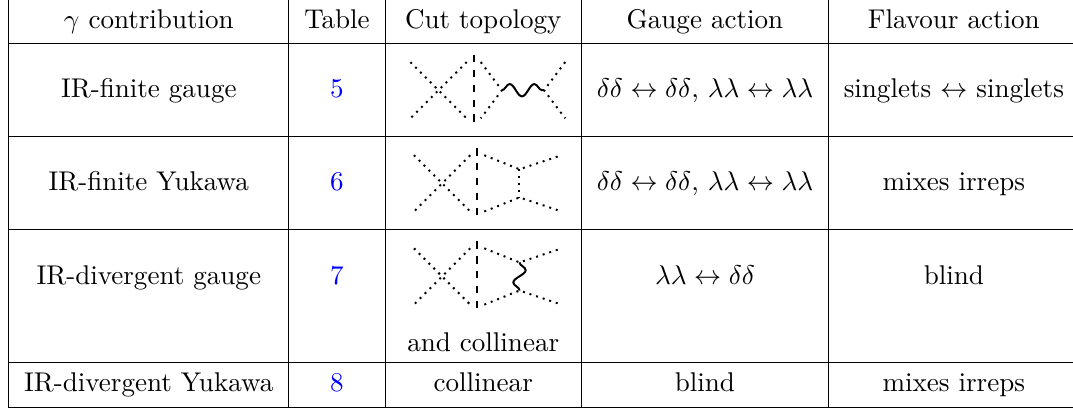
Table 4 . Different types of contributions to the anomalous dimensions, and how they act. δδ and λλ refer to the gauge structure of the operator: δδ means that the operator is constructed out of two currents which are singlets under a gauge group, while λλ means that the operator is constructed out of two currents both of which are either SU(2) triplets or SU(3) L c